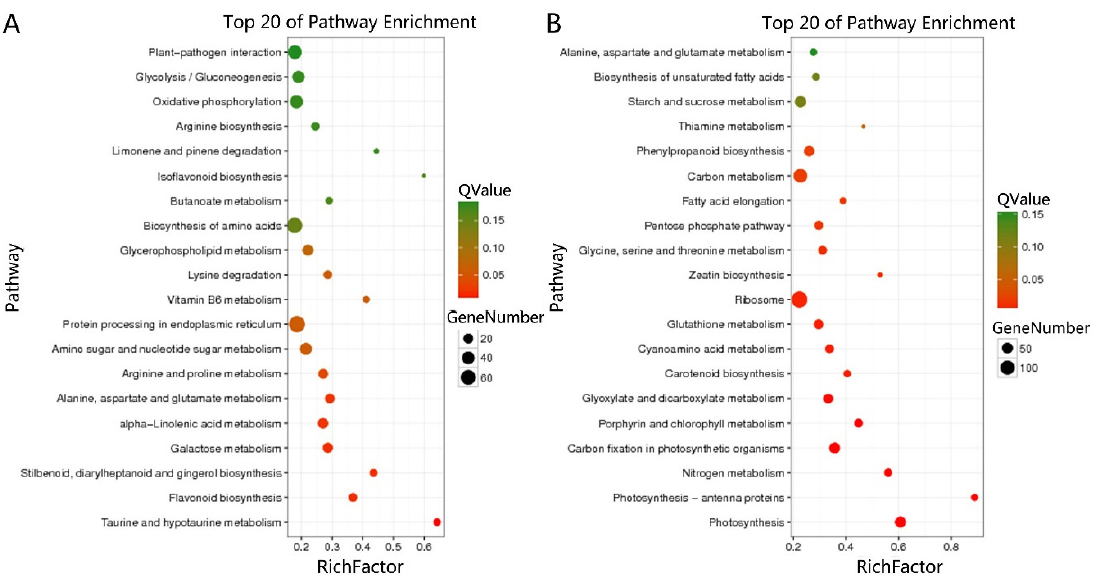
Figure 8. Kyoto Encyclopaedia of Genes and Genomes (KEGG) enrichment analysis of differentially expressed genes (DEGs) between drought-treated P. ostii and the control. ( A ) Top 20 upregulated pathways. ( B ) Top 20 downregulated pathways.